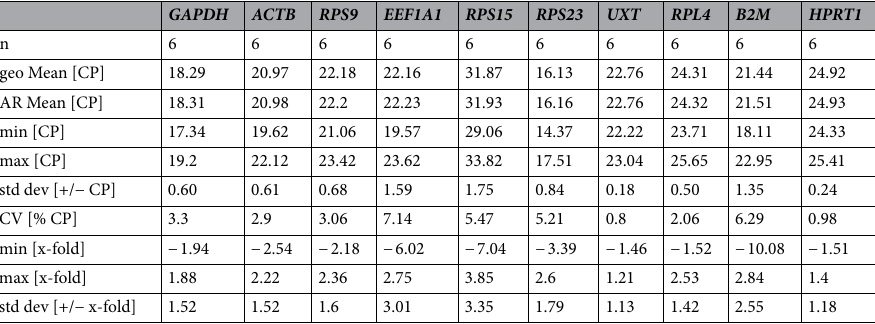
Table 6. Analysis of parameters based quantitative cycling points (CP) for 10 candidate RGs in